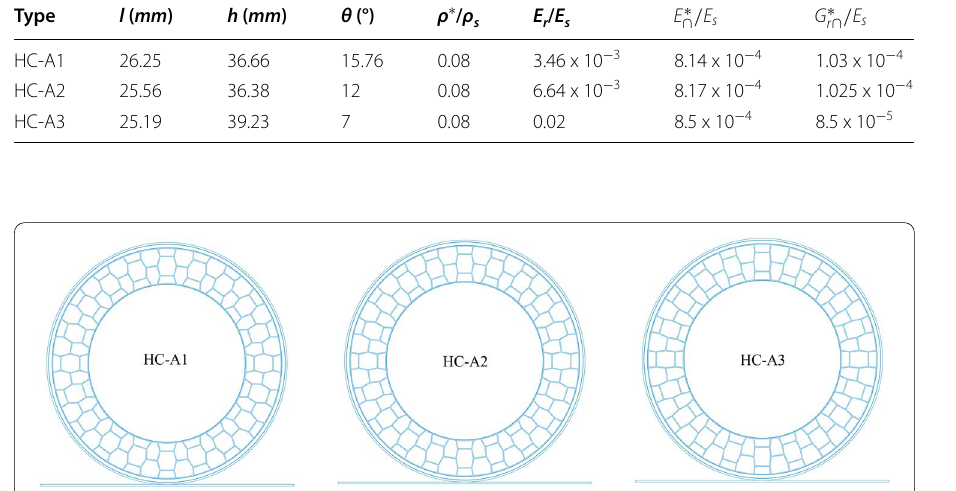
Fig. 3 Honeycomb spokes-based NPTs with the same wall thickness with different cell